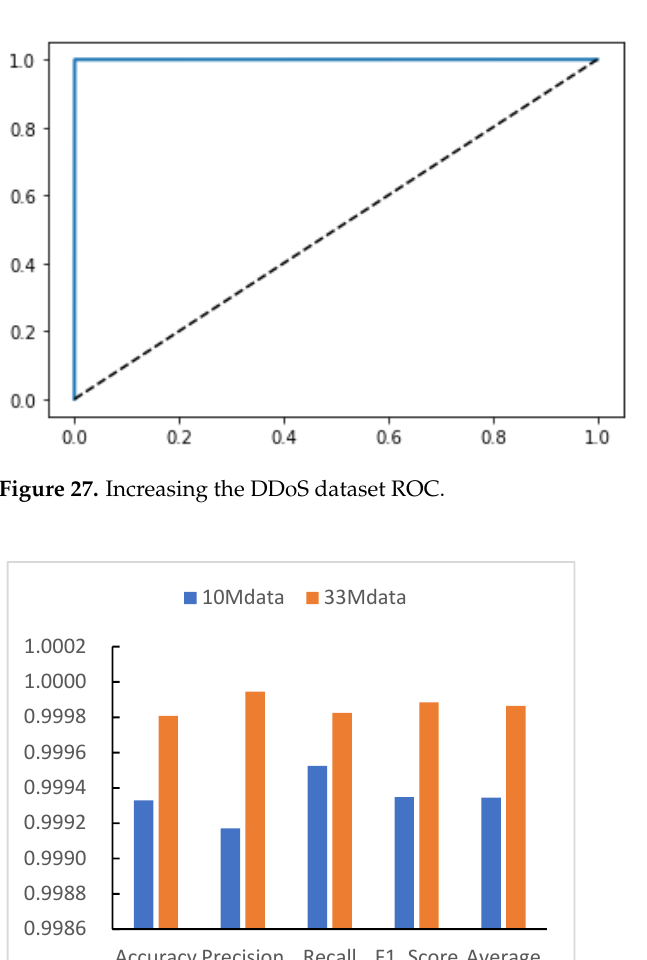
Figure 29. Performance demonstration with changing DDoS dataset. Figure 30. Changing the DDoS dataset confusion matrix.